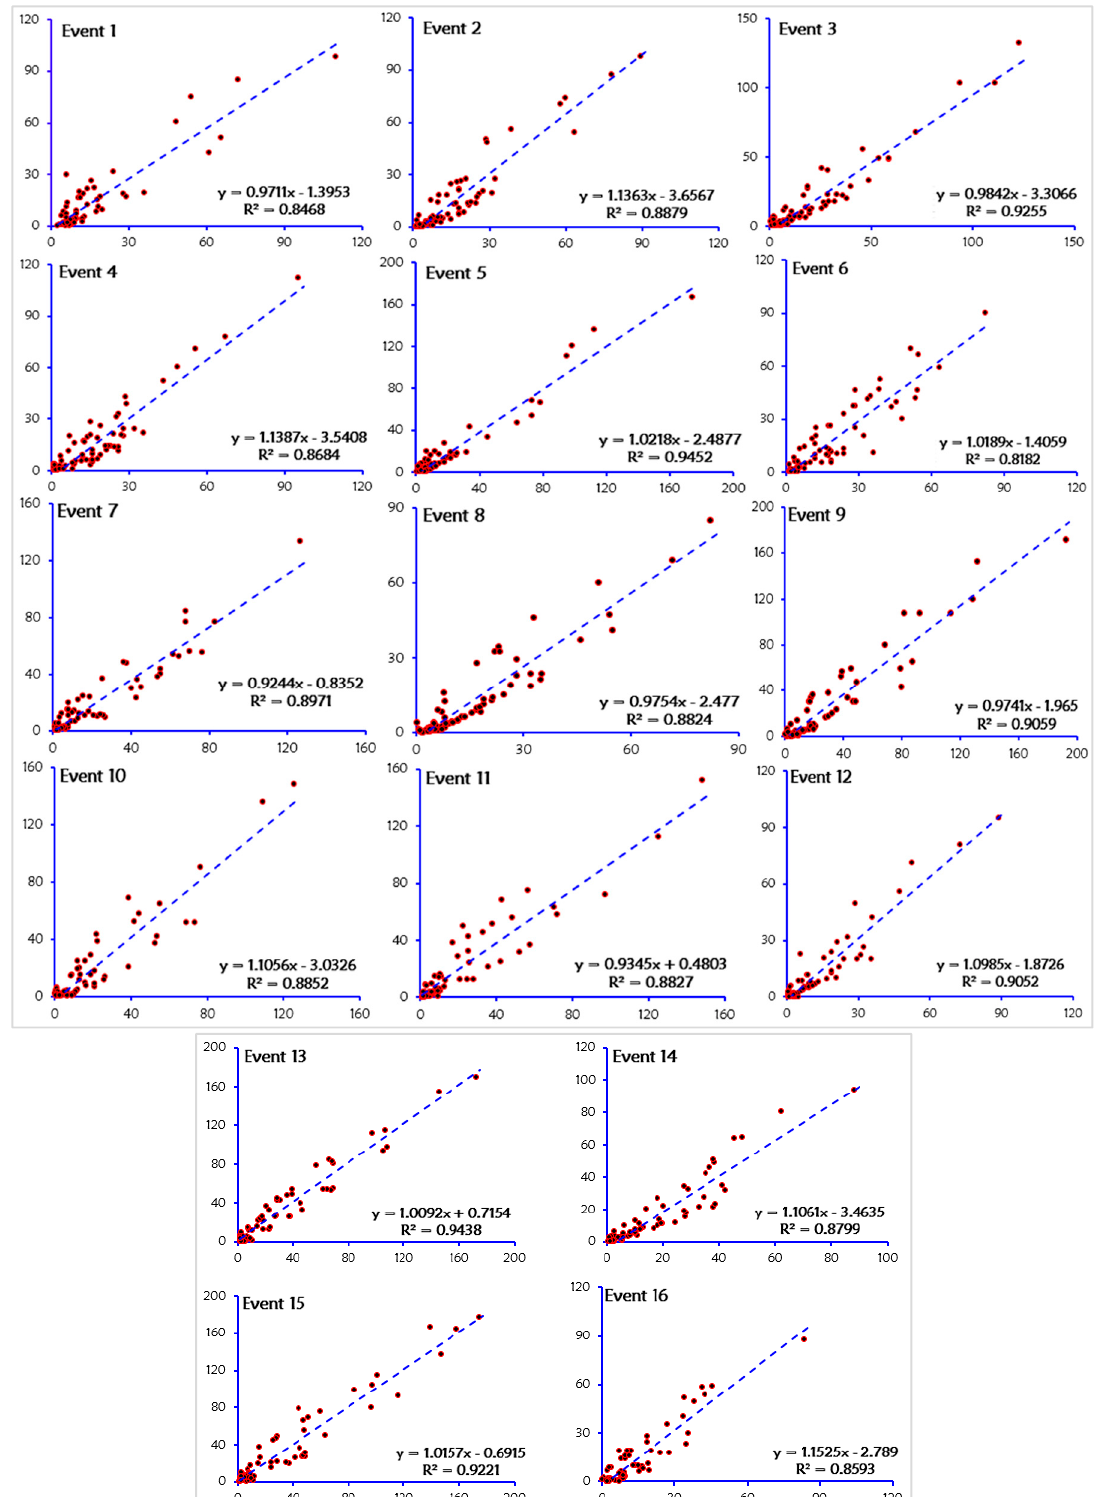
Figure 9. Relationships between simulated and observed flow for calibration and validation.